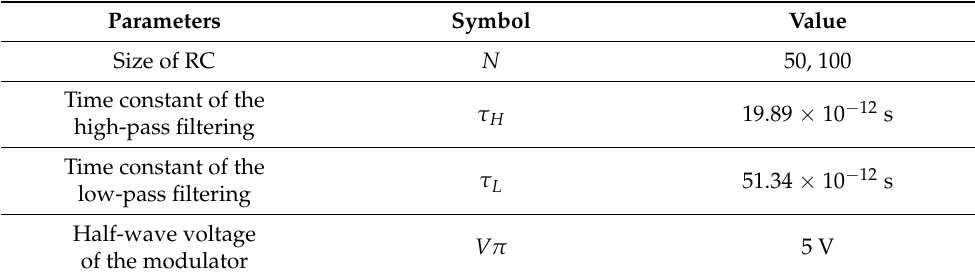
Table 1. The typical values of several parameters in the